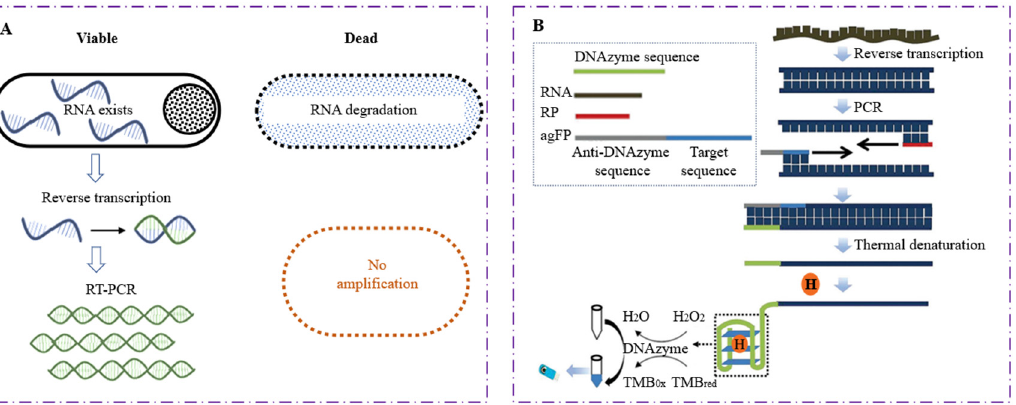
Figure 1. Principle diagram of viable bacteria detection based on RT-PCR. ( A ) Schematic diagram conventional RT-PCR amplification; ( B ) Schematic diagram of electrochemical biosensor for detection of Cronobacter sakazakii by RT-PCR-triggered G-quadruplex DNA enzyme catalytic reaction [8].